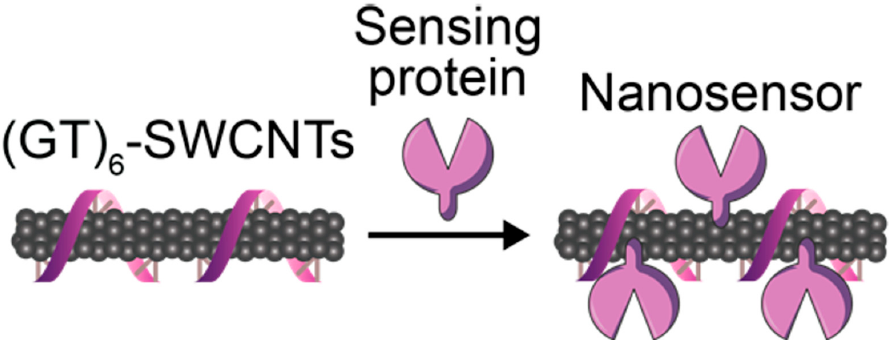
Figure 11. Schematic representation of fabrication of ACE2-(GT)6-SWCNTs nanosensor using ACE2 as a sensing protein. Image reproduced with permission from [179]. Copyright 2021 American Chemical Society.